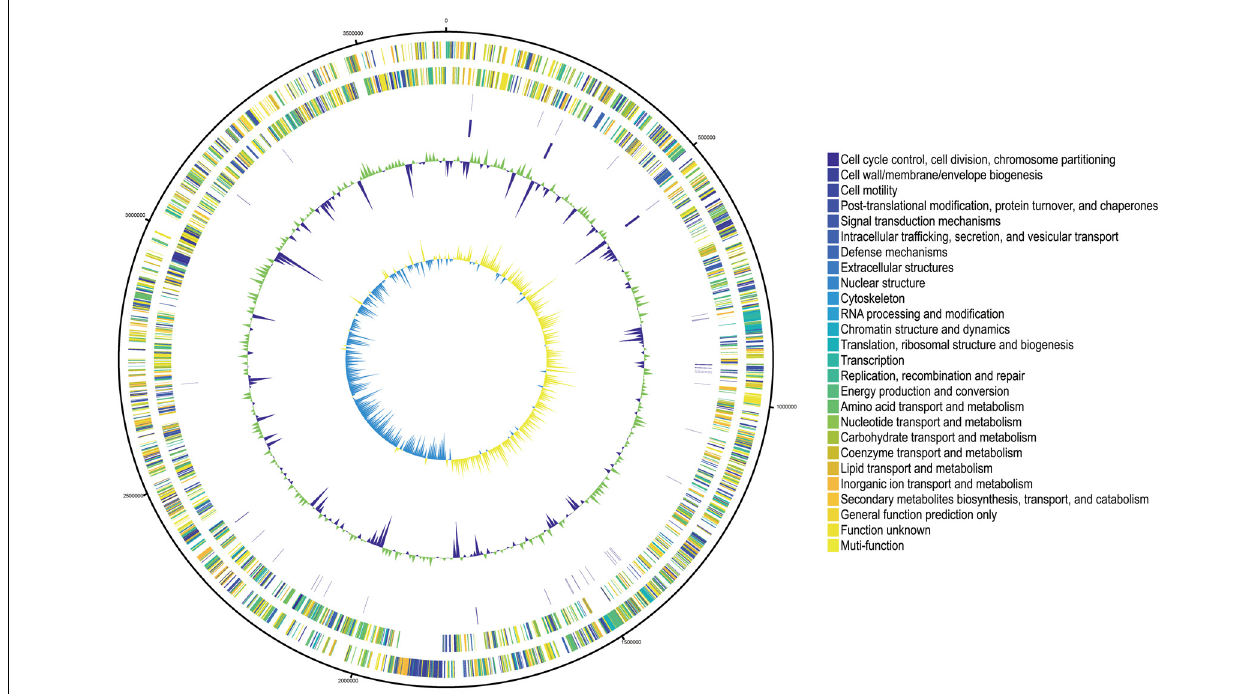
FIGURE 1 | Circular representation of the S. acidaminiphila strain SUNEO genome. Predicted Coding Sequences (CDSs) are assigned various colors with respect to cellular functions. The Circles display from the outermost to the innermost: (1) DNA coordinates. (2,3) Function-based color coded mapping of the CDSs predicted on the forward and reverse strands, respectively. (4,5) tRNA and rRNA genes, respectively. (6) GC plot with regions above and below average in green and violet, respectively. (window size: 10,000 bp). (7) GC skew showing regions above and below average in yellow and light blue, respectively. (window size: 10,000 bp).